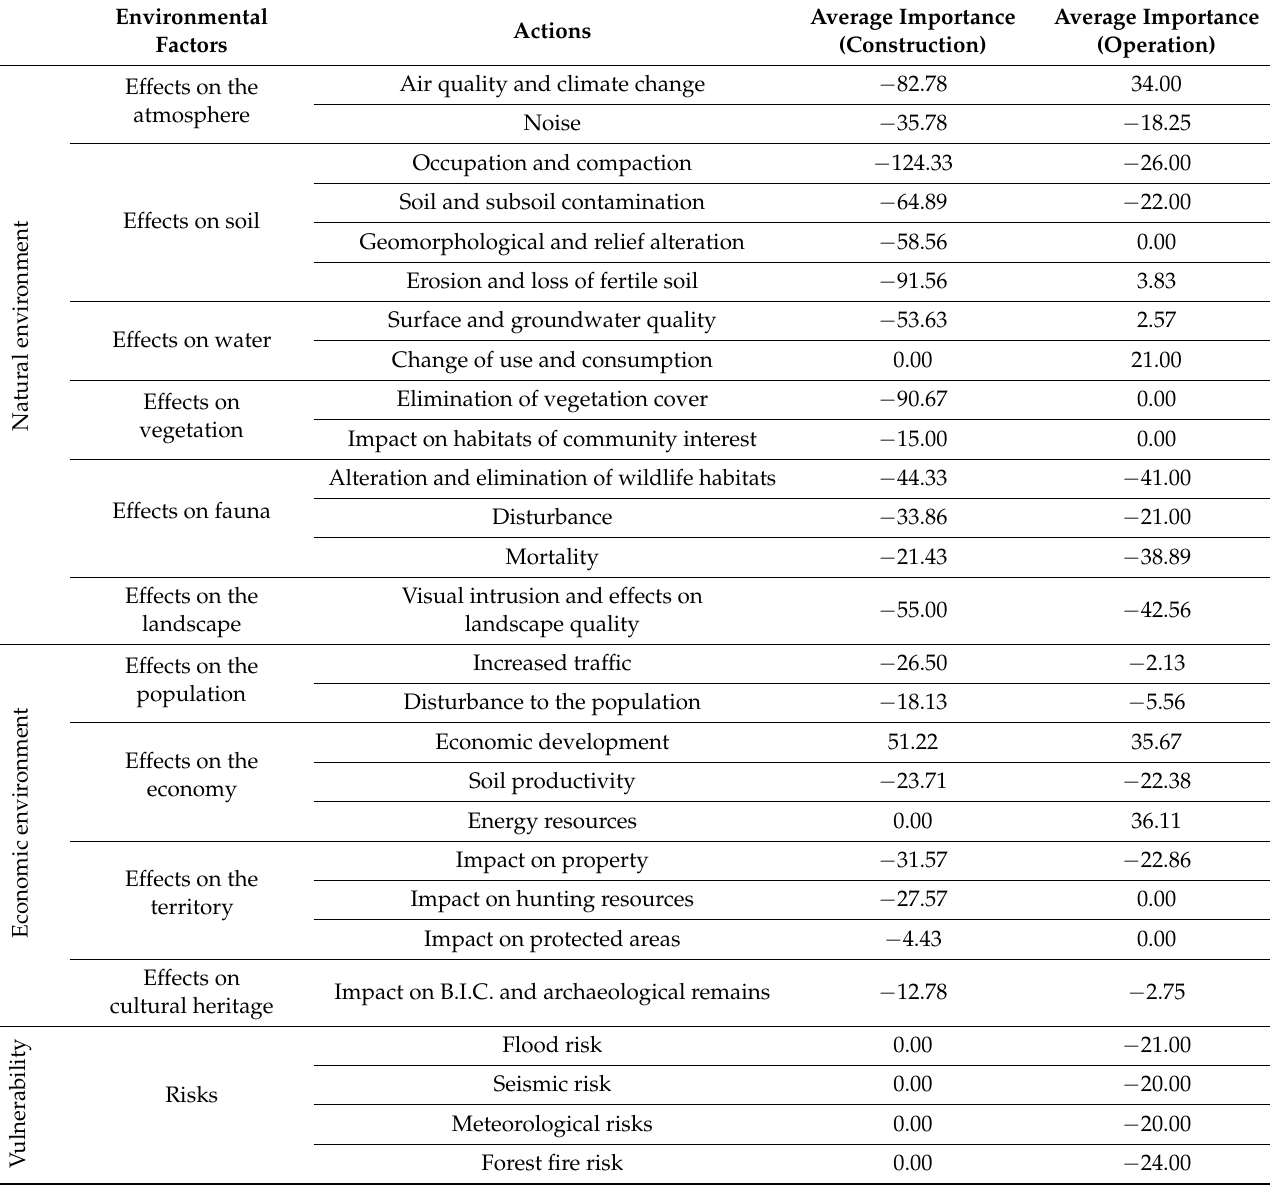
Table 6. Environmental factors with its actions and average importance at different stages of the solar plants studied. Adapted from